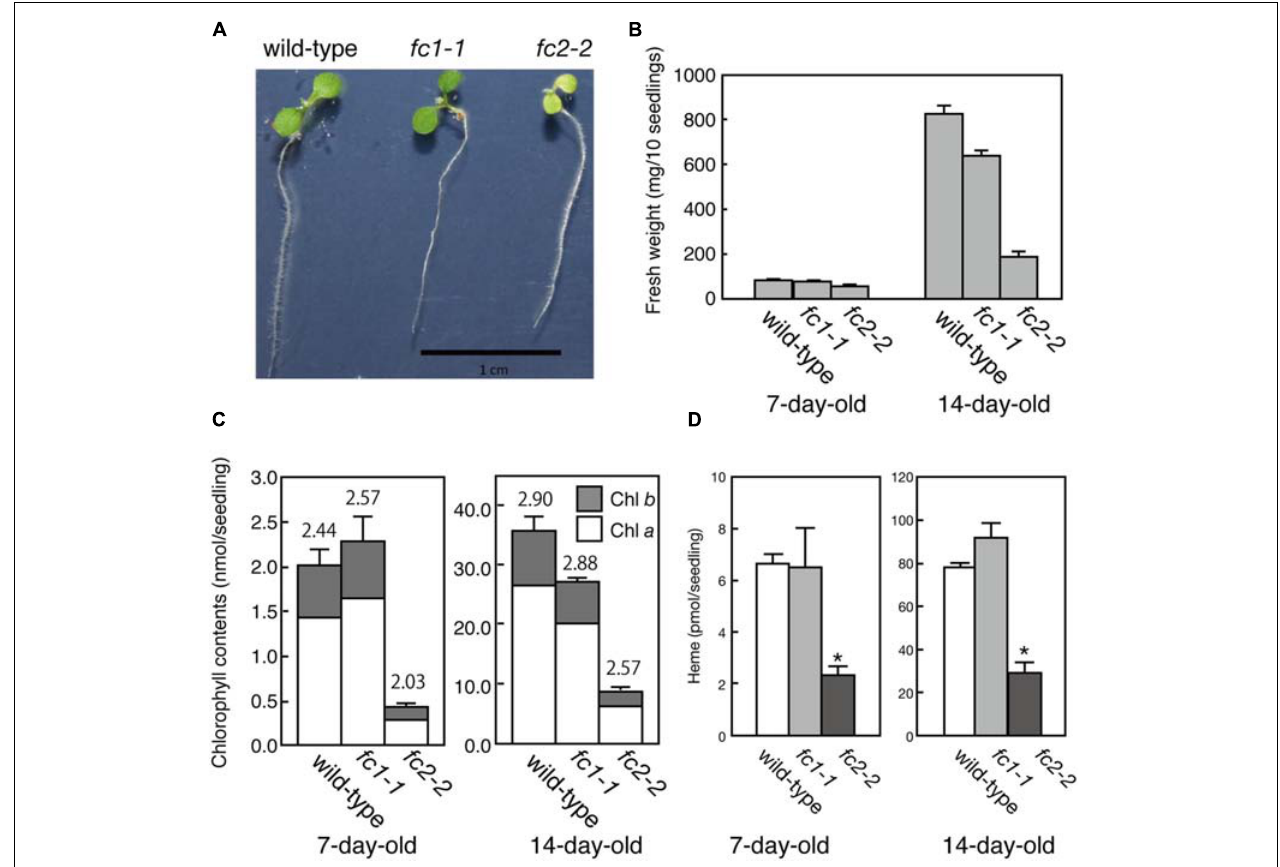
FIGURE 2 | Phenotypic characterization of fc1-1 and fc2-2 . (A) Photographs of 7-day-old wild-type, homozygous fc1-1 , and homozygous fc2-2 seedlings. Seedlings of fc2-2 show pale-green phenotype. (B) Fresh weights of wild-type, fc1-1 , and fc2-2 of 7- and 14-day-old seedlings. (C) Chlorophyll contents of wild-type, fc1-1 , and fc2-2 of 7- and 14-day-old seedlings. Chlorophyll a (white bars) and b (gray bars) contents are indicated. Numbers on the bars are chlorophyll a / b ratio. (D) Total endogenous heme contents in 7- and 14-day-old seedlings in wild-type, fc1-1 , and fc2-2. Asterisks indicate a significant difference from the wild-type ( ∗ P < 0.05, Student t -test). In all figures, bars indicate standard error of the mean (SEM) from three independent experiments.